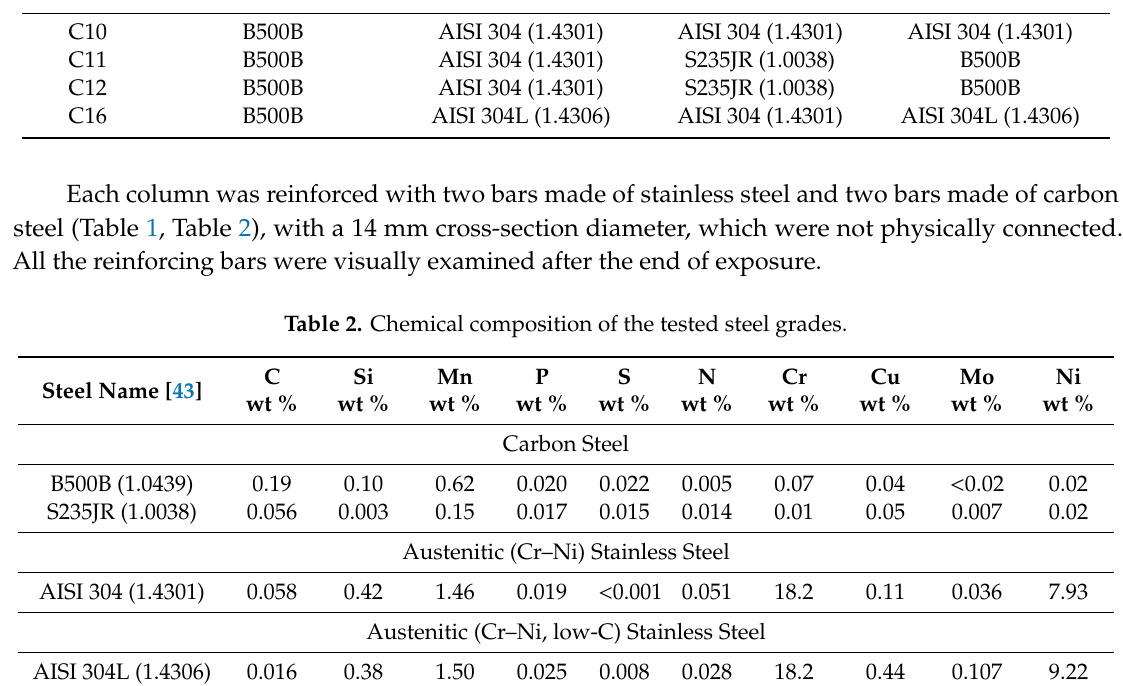
Table 1. Type of steel reinforcement bars, ER probes, and CMEs, embedded in each concrete column. Column